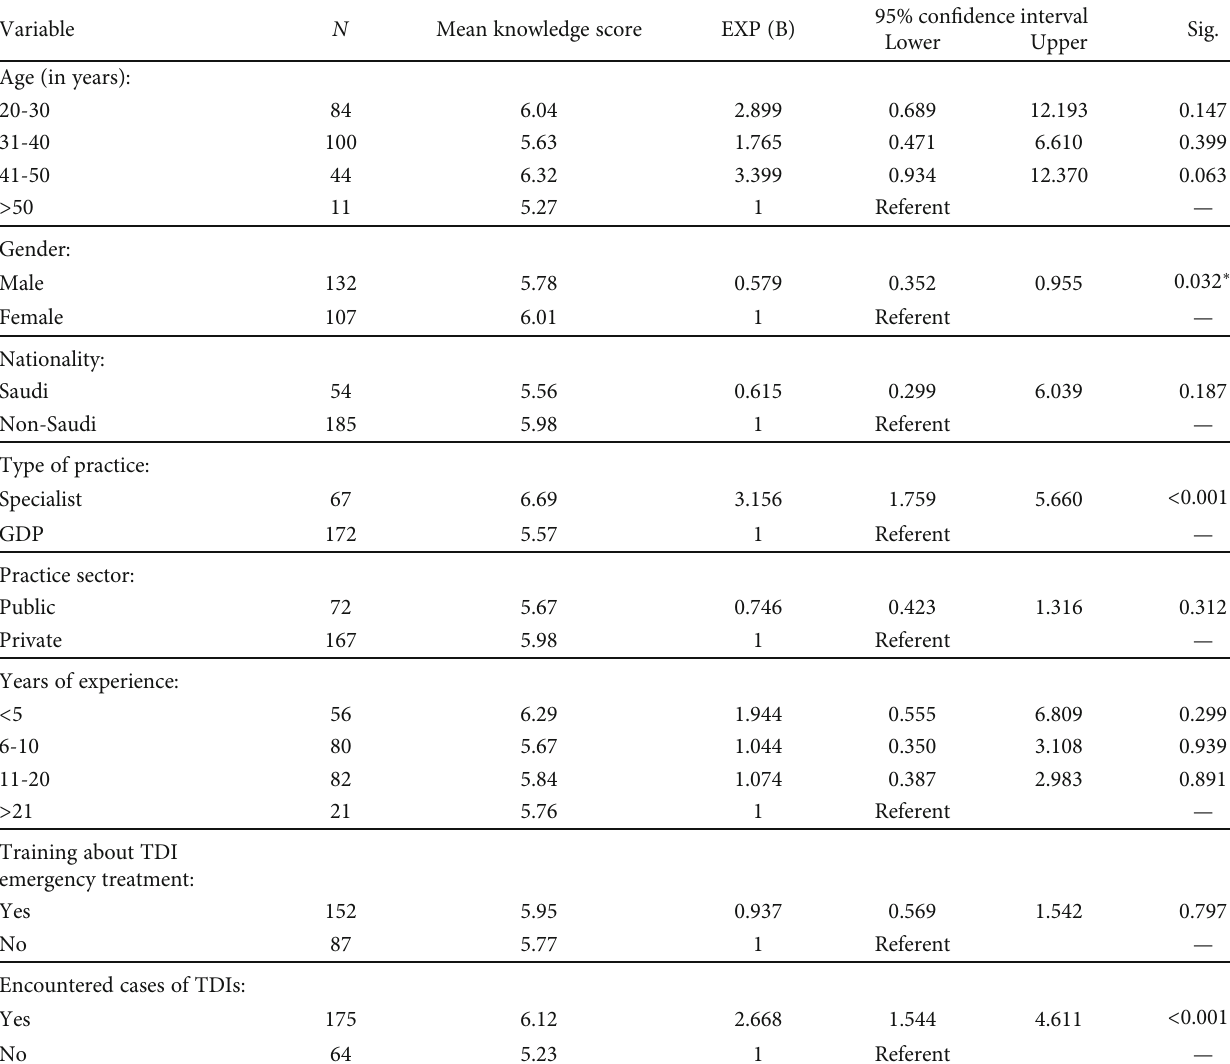
Table 5: Frequency of dentists according to demographic data and association with knowledge